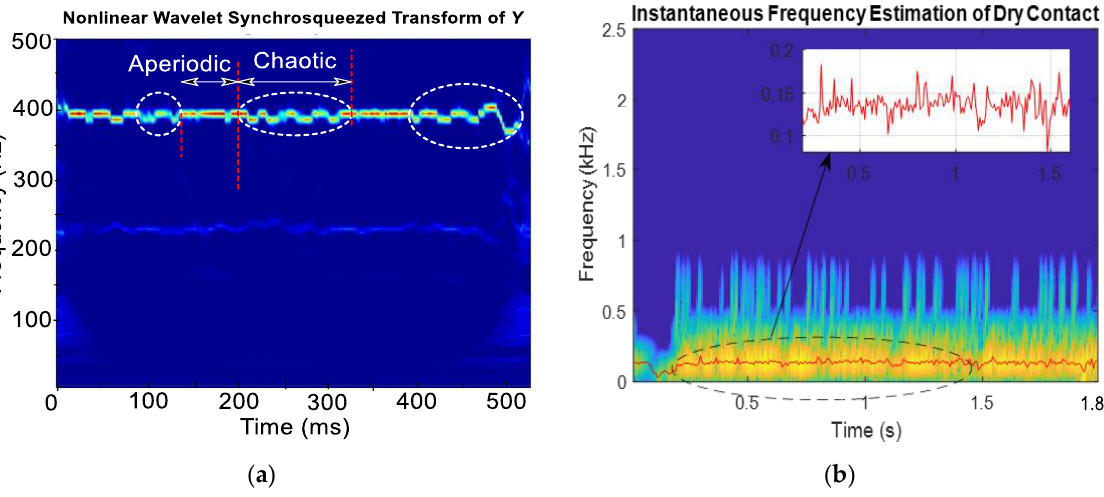
Figure 13. No fluid-NWSST representation of the rotor-casing rubbing signal in the Y direction. ( a ) Time-frequency ridges from NWSST; ( b ) Estimated IF amplitude spectrum of the signal. The corresponding estimated frequency spectrum (red line) extracted by the